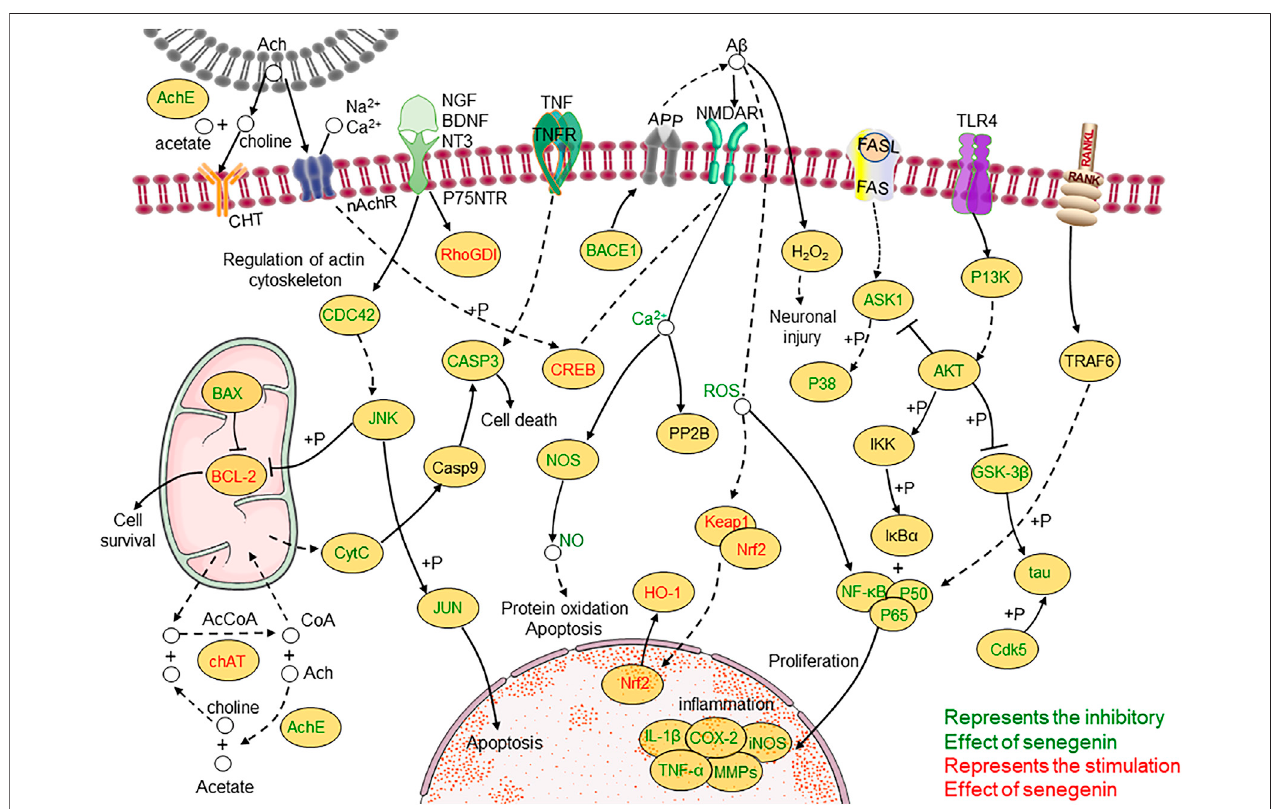
FIGURE 2 | Molecular pathways involved in the pharmacological activities of